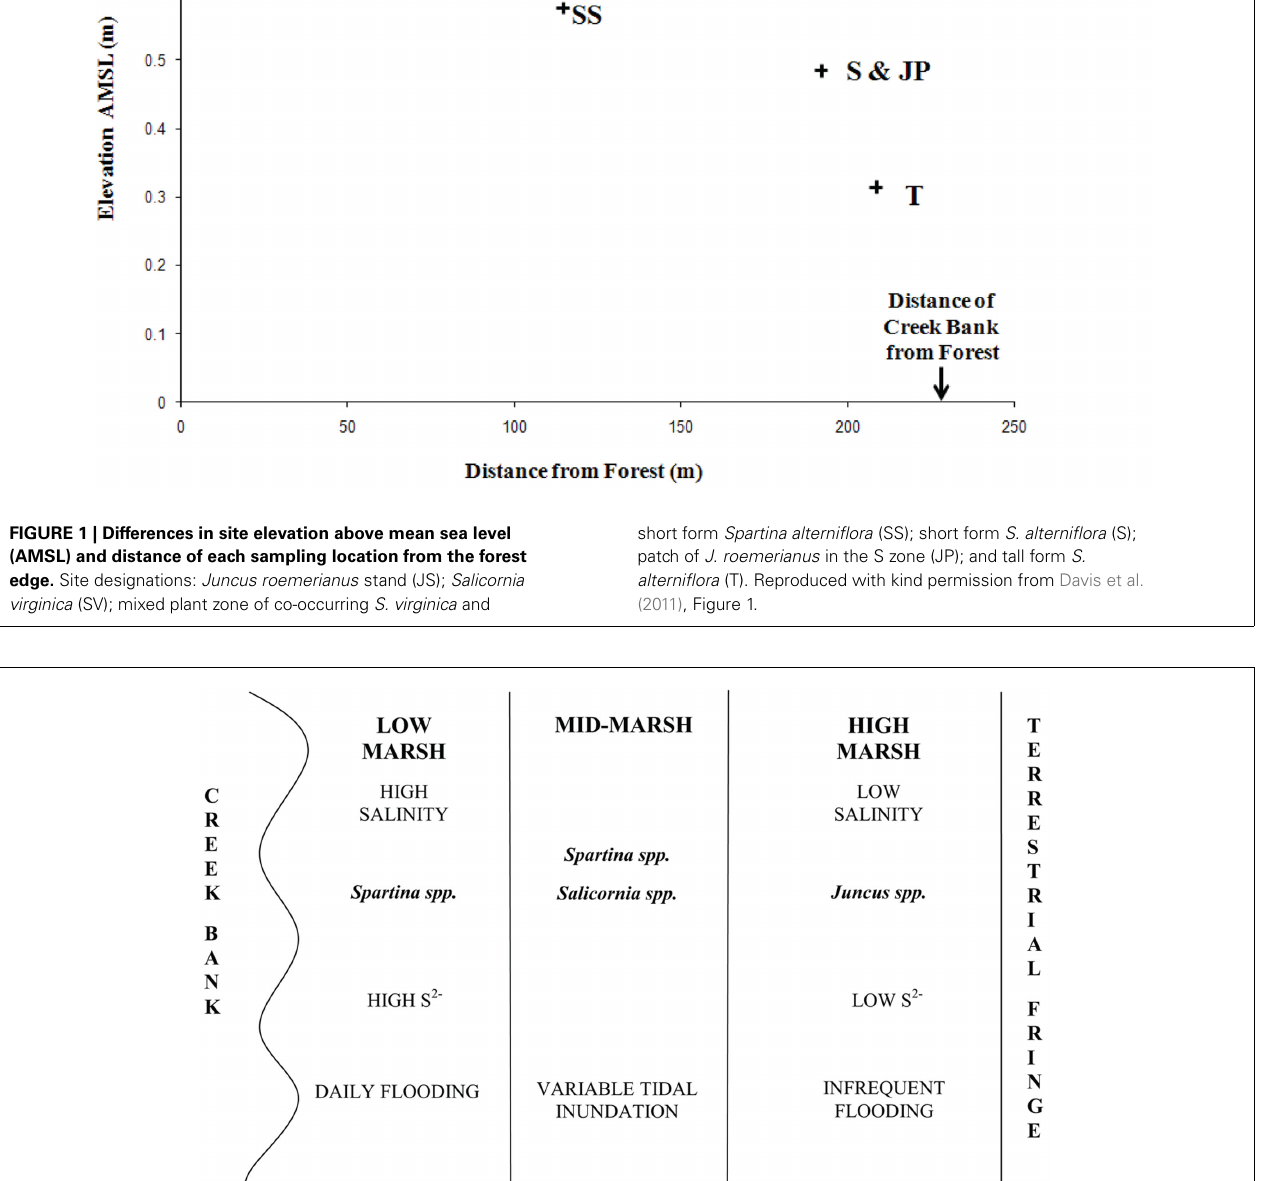
FIGURE 2 |Typical marsh zonation including vegetation zonation and gradients of influential abiotic parameters as observed in Crab Haul Creek Basin, North Inlet.